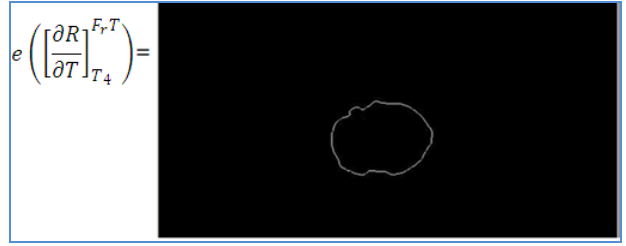
At this point of temperature the red alarm would be triggered and the monitoring sequence would be continuous. Analyzing of thermal region between the temperature interval of red alarm (T 4 ) and fire-break out point (F r T) is simulated and the boundary of the temperature affected area with respect to the derived equation of boundary detection process is shown in Fig. 20 as follows: